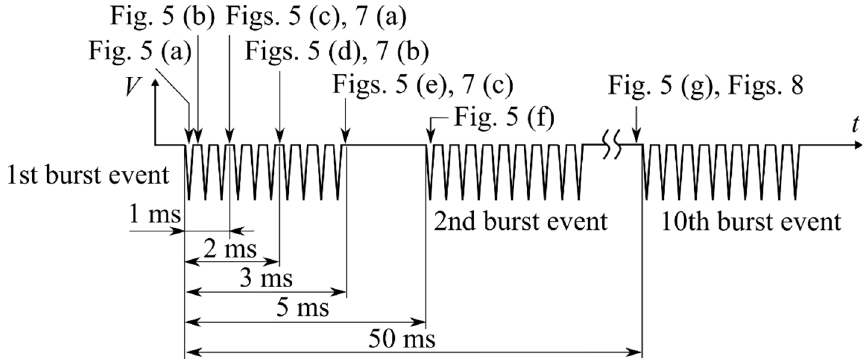
Figure 4. Timing chart of the Schlieren image acquisition. The input signal in Case 5 is shown.